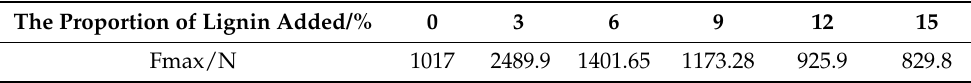
Table 4. Relationship between lignin addition ratio and F